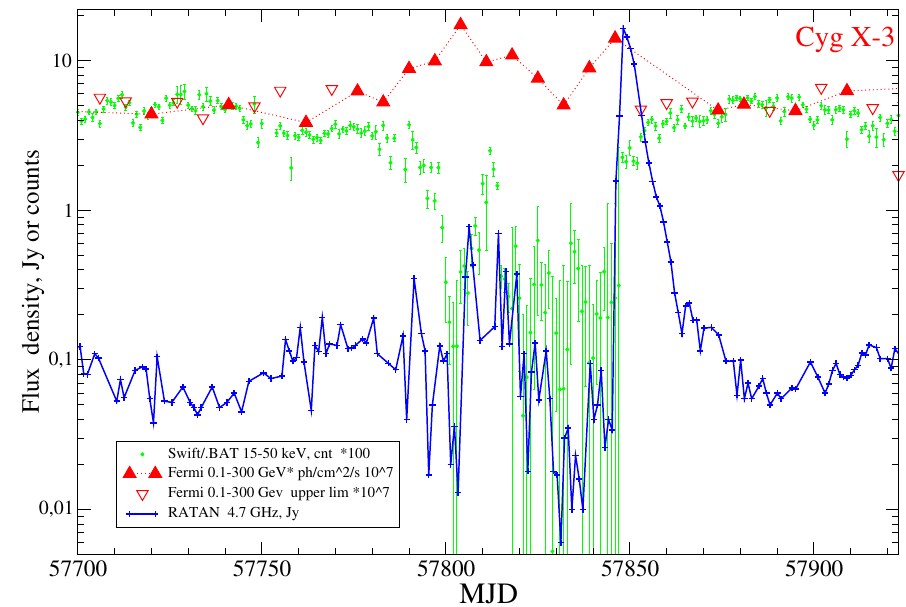
Figure 3. The light curves during the flare in April 2017 with data from Swift/BAT (15–50 keV) and the Fermi Gamma-ray Space Telescope, LAT (0.1–300